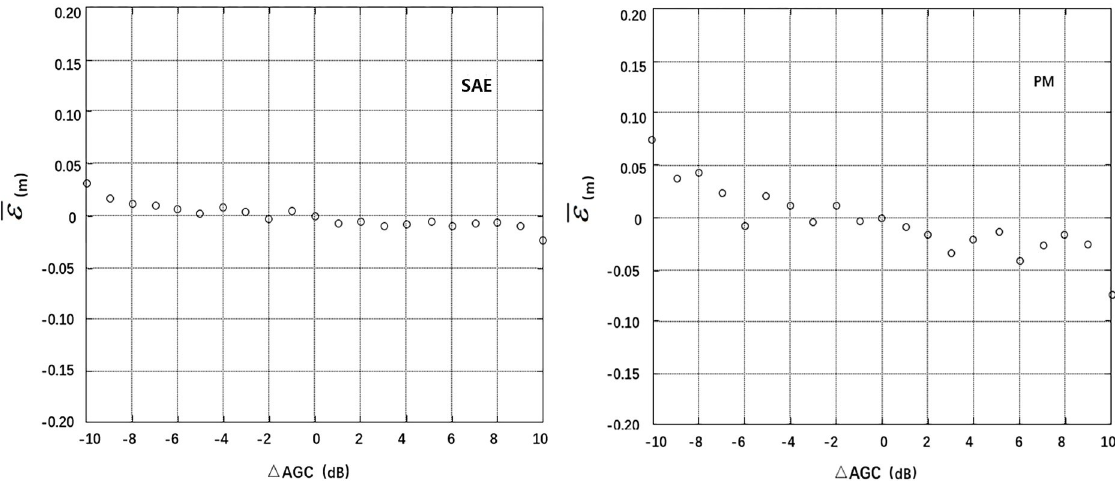
Fig 7. Distributions of mean residuals � ε according to Δ